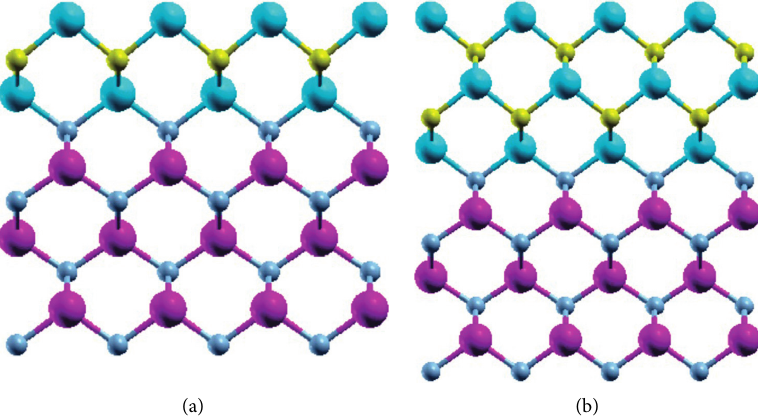
Figure 5: Epitaxial growth of (a) a GeC bilayer and (b) two GeC bilayers on the Ge-terminated surface.